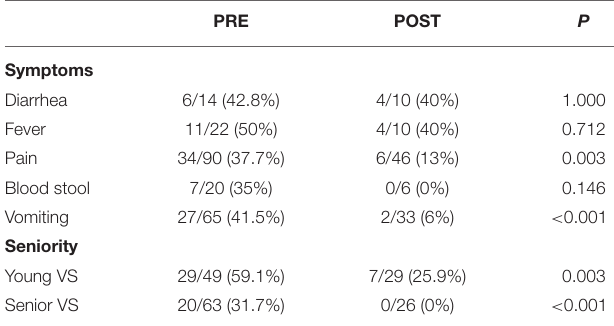
TABLE 1 | Comparison of clinical characteristics and laboratory values between the PRE and POST groups. PRE